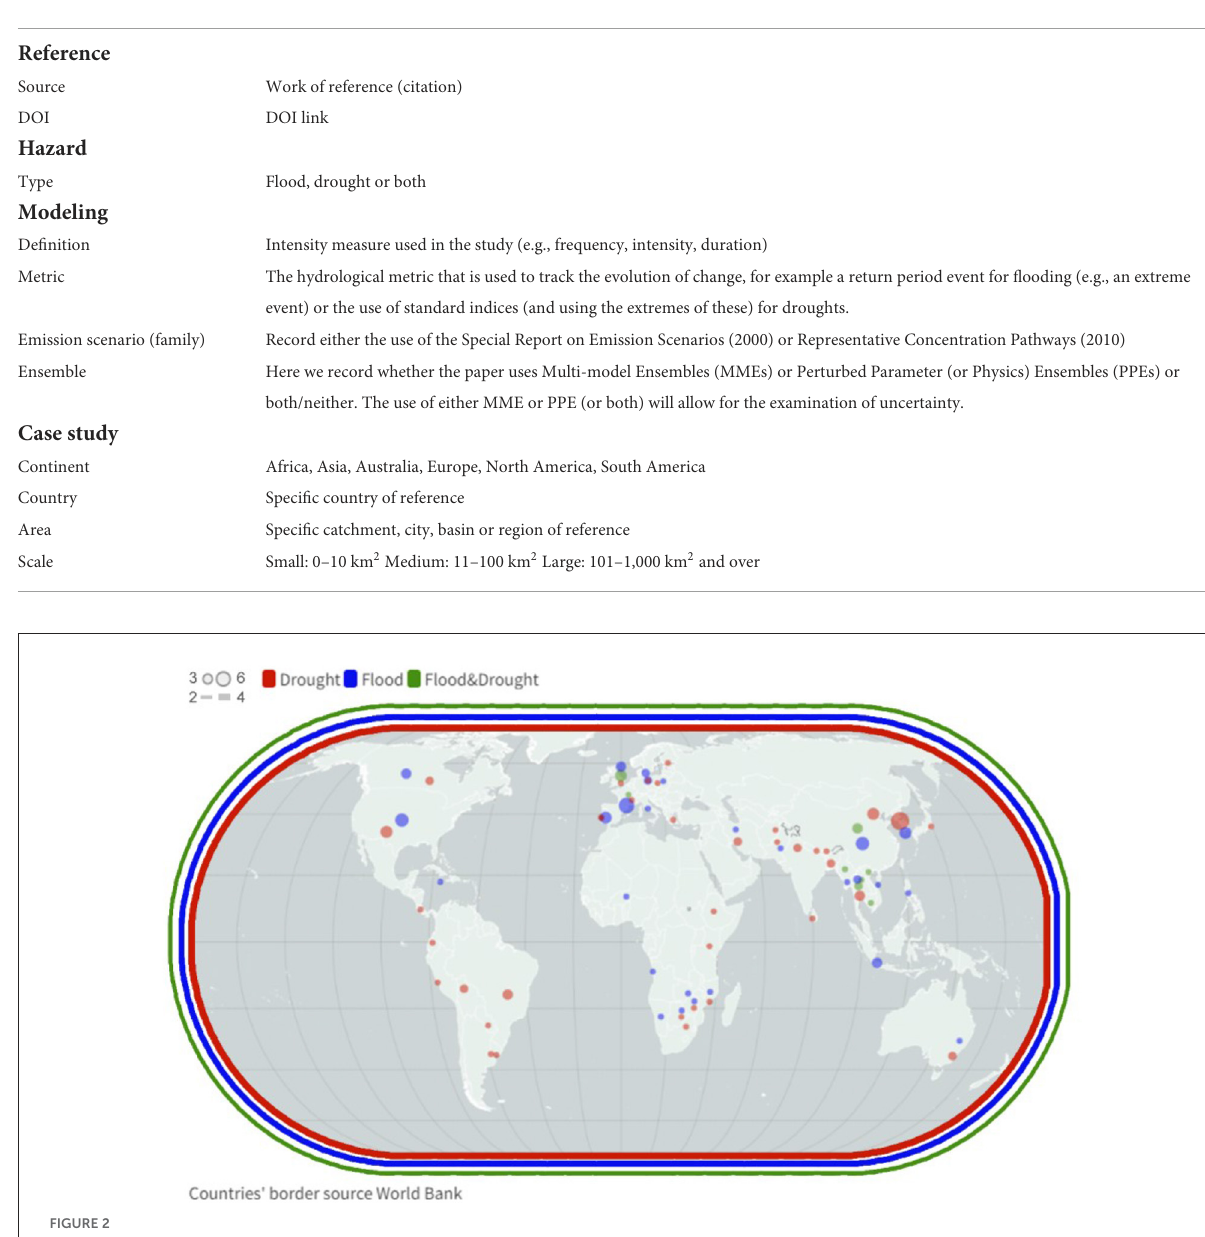
TABLE 1 List of parameters considered when reviewing the literature (which appear as Table headings for Appendix A).